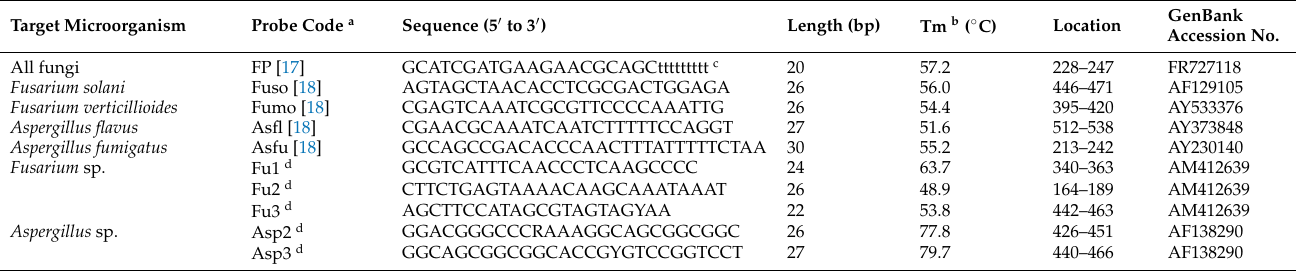
Figure 1. The layout of a novel dot hybridization array for detecting fungal keratitis. The universal fungal probe FP in the layout (0.6 × 0.6 cm) was designed for detecting all fungal species (Table 2). The genus probes “Fu1”, “Fu2”, and “Fu3” were designed to detect all Fusarium sp. The probes “Fuso” and “Fumo” were used to identify F. solani and F. verticillioides , respectively. The genus probes “Asp2” and “Asp3” were designed to detect all Aspergillus sp. The probes “Asfl” and “Asfu” were used to identify A. fumigatus and A. flavus , respectively. The dot “NC” is a negative control (tracking dye only). The probe “M” is a position marker, i.e., a digoxigenin-labeled oligonucleotide probe (digoxigenin-GCATATCAATAAGCGGAGGA). Table 2. Probes used in the dot hybridization array.